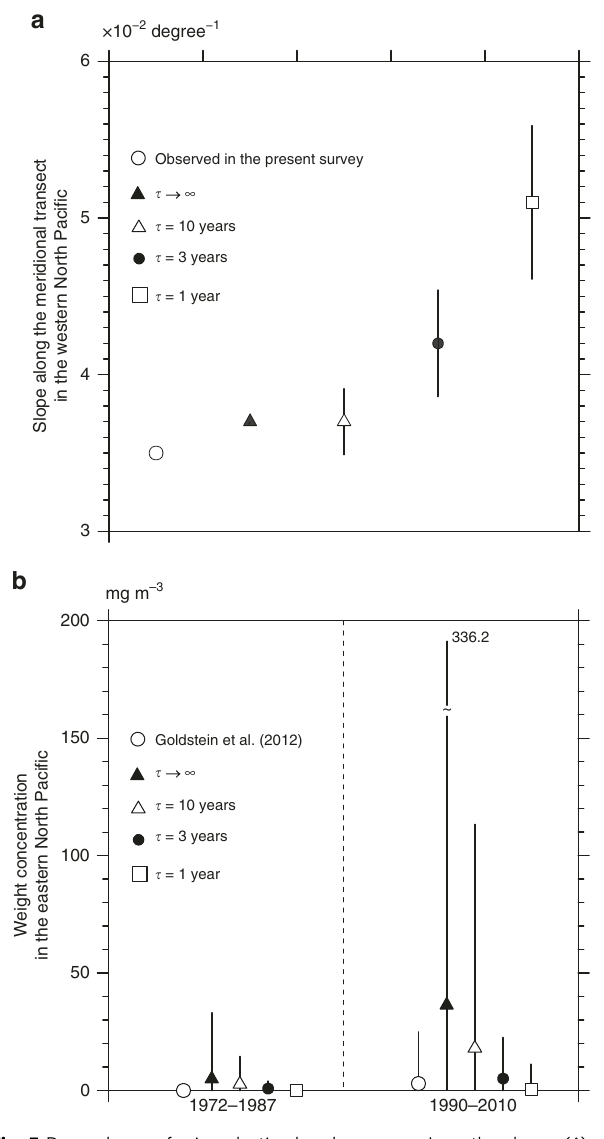
Fig. 5 Dependence of microplastic abundance on τ . In a , the slopes ( λ ) of the exponential curve representing the meridional variation of the total particle counts are compared between the meridional transect in 2016 and models with a different average transit time ( τ ) in the North Paci fi c. In b , weight concentrations averaged between 1972 and 1987 are compared with those averaged between 1990 and 2010 using the estimates given by Goldstein et al. 3 and models with a different τ . The weight concentrations were averaged over the box from 130°W to 170°W, and from 20°N to 40°N. The marks denote the median for each case, while the upper (lower) end of the bars represents the 95th (5th) percentile in line with the estimate by Goldstein et al. 3 . The 95th percentile for the model without the sink (i.e., τ → ∞ ) in 1990 – 2010 is shown by the digit at the top of the bar because the value exceeds the upper limit of